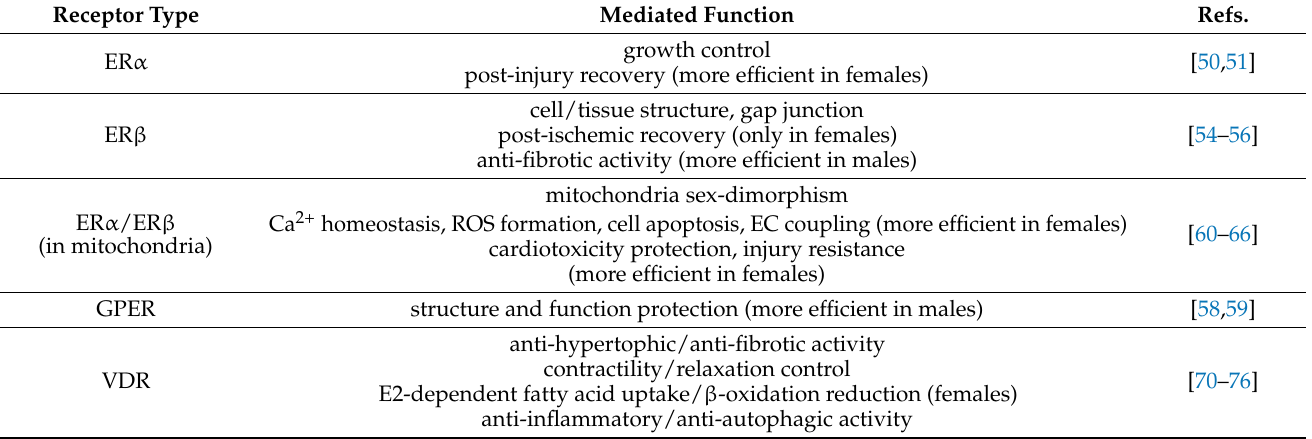
Table 1. Estrogen receptor (ER) and vitamin D receptor (VDR) in cardiomyocytes. The table summarizes the main intra-cellular effects mediated by ER sub-types and VDR, affecting cardiomyocyte remodeling. Receptor